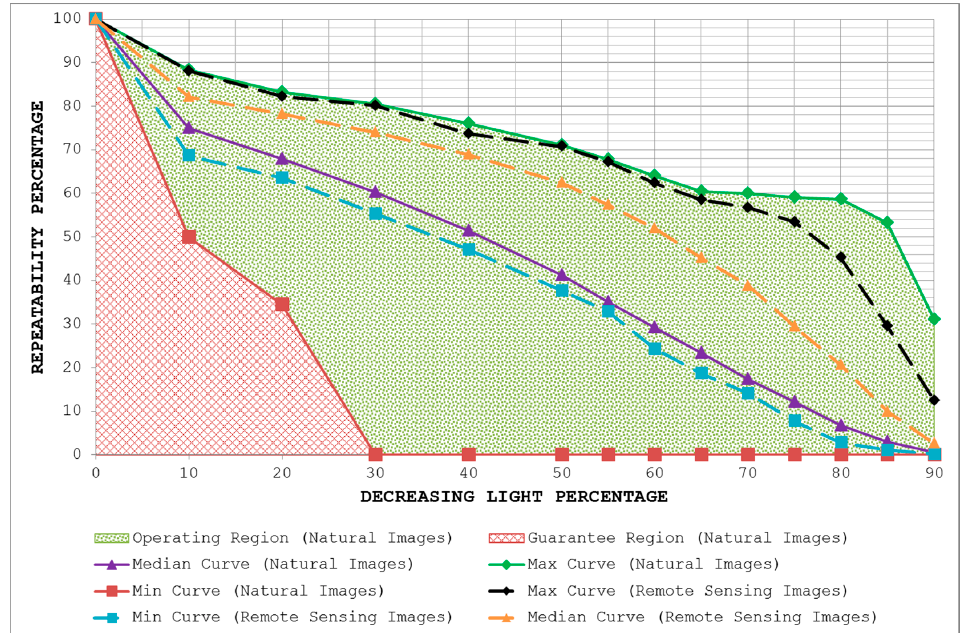
Figure 25. Results of IBR for remote sensing images under decreasing light. The two graphs (natural images and remote sensing images) are overlaid to produce one plot for IBR. Note that although the operating and guarantee regions are defined using the presented database of natural images [50], the curves (median, max and min) in the case of remote sensing images still lie inside the defined operating region and do not cross over to the guarantee region.